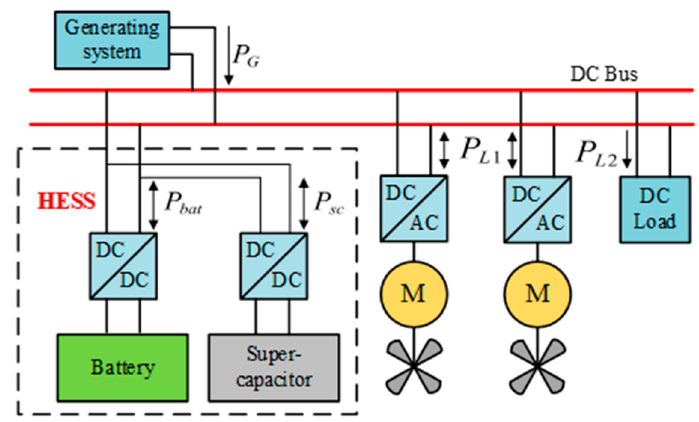
Figure 1. The basic structure of HESS for DEPA.